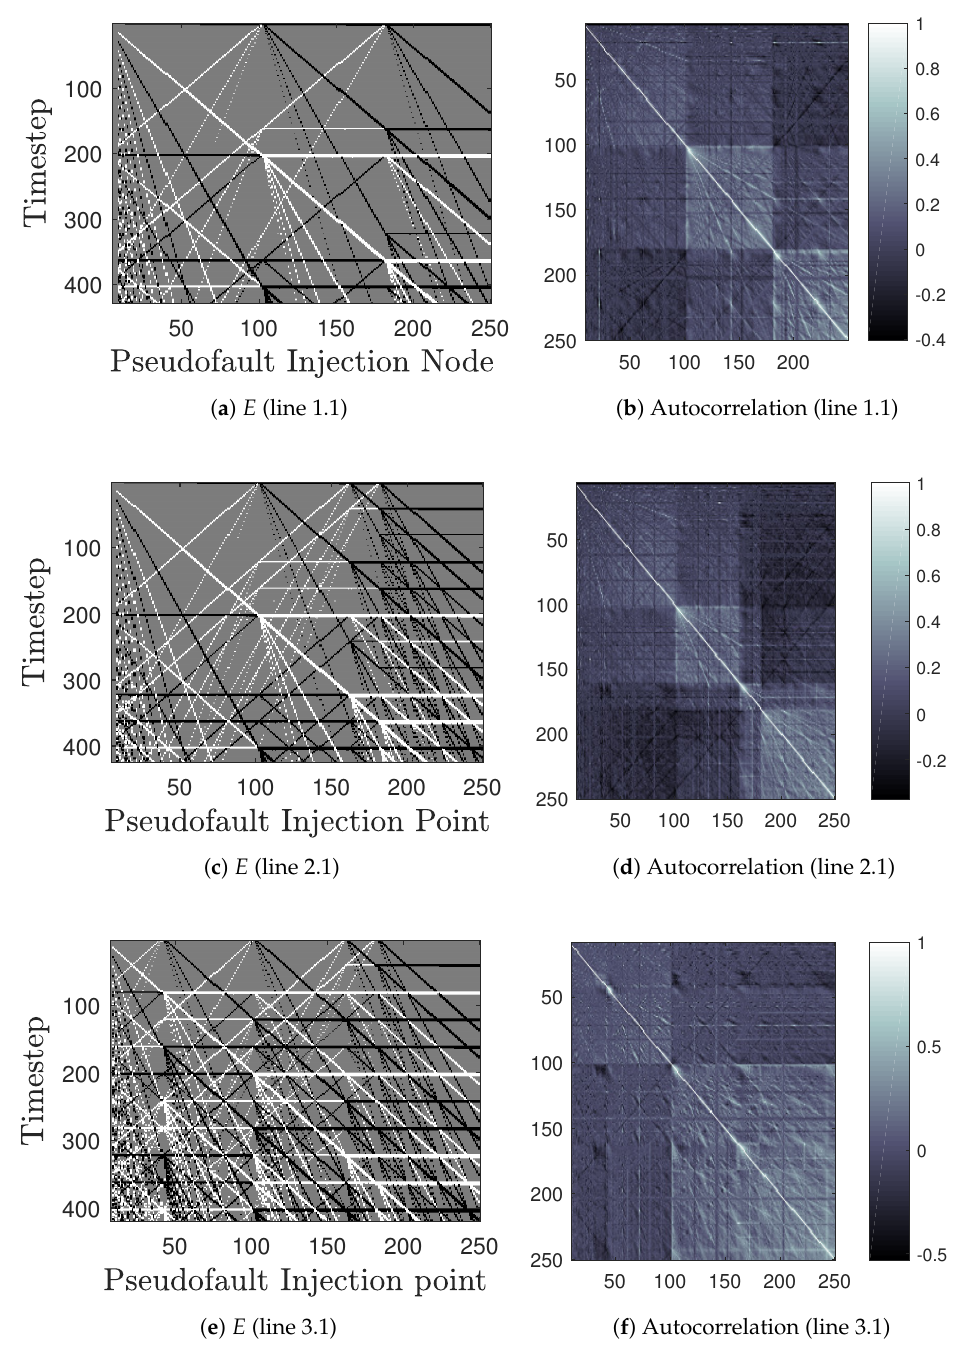
Figure 5. Expected energy E graphs ( left ) and their associated autocorrelation functions ( right ). For the autocorrelations, representing a correlation of +1. Notably, the correlation < 1 outside this